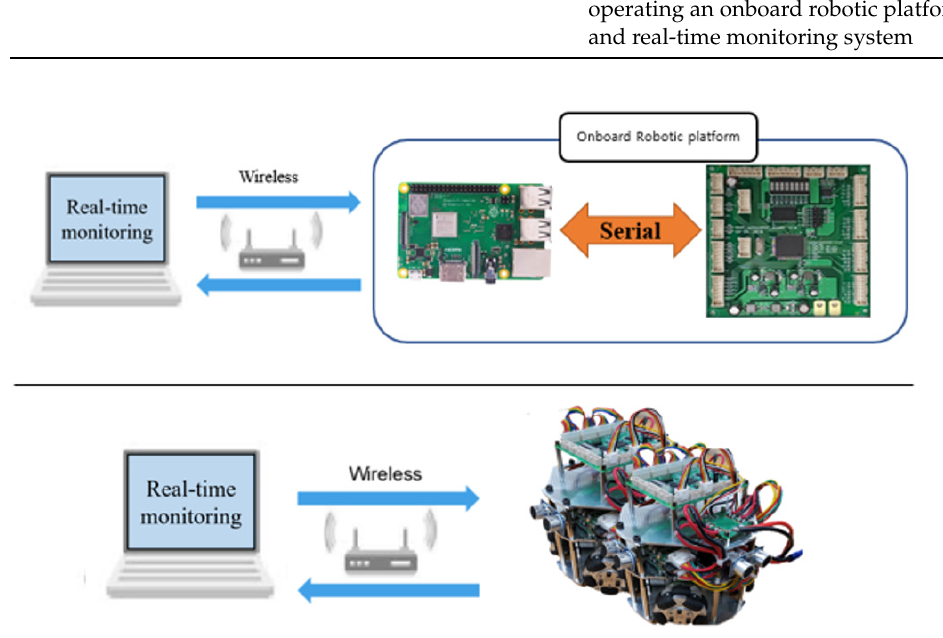
Figure 7. Implementation of the real-time monitoring system via the MATLAB Simulink hardware support